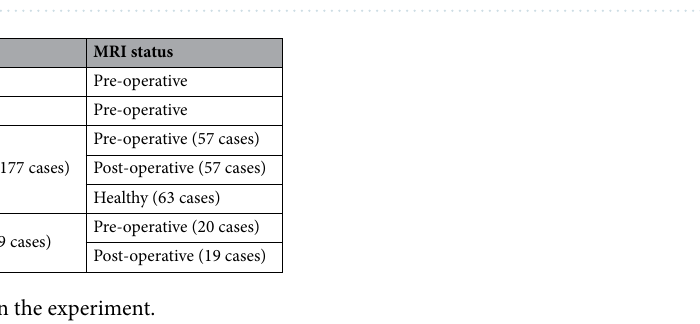
Figure 2. The proposed deep neural network architecture for skull stripping. The blue and green blocks represent feature maps from two different convolutional operations. The former features are obtained from a conv3d computation, while the latter from a conTranspose3d operation. The gray arrow represents a conv3d computation.